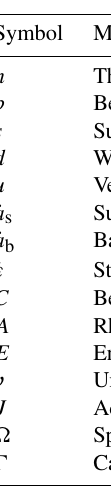
Table A1. Mathematical symbols.